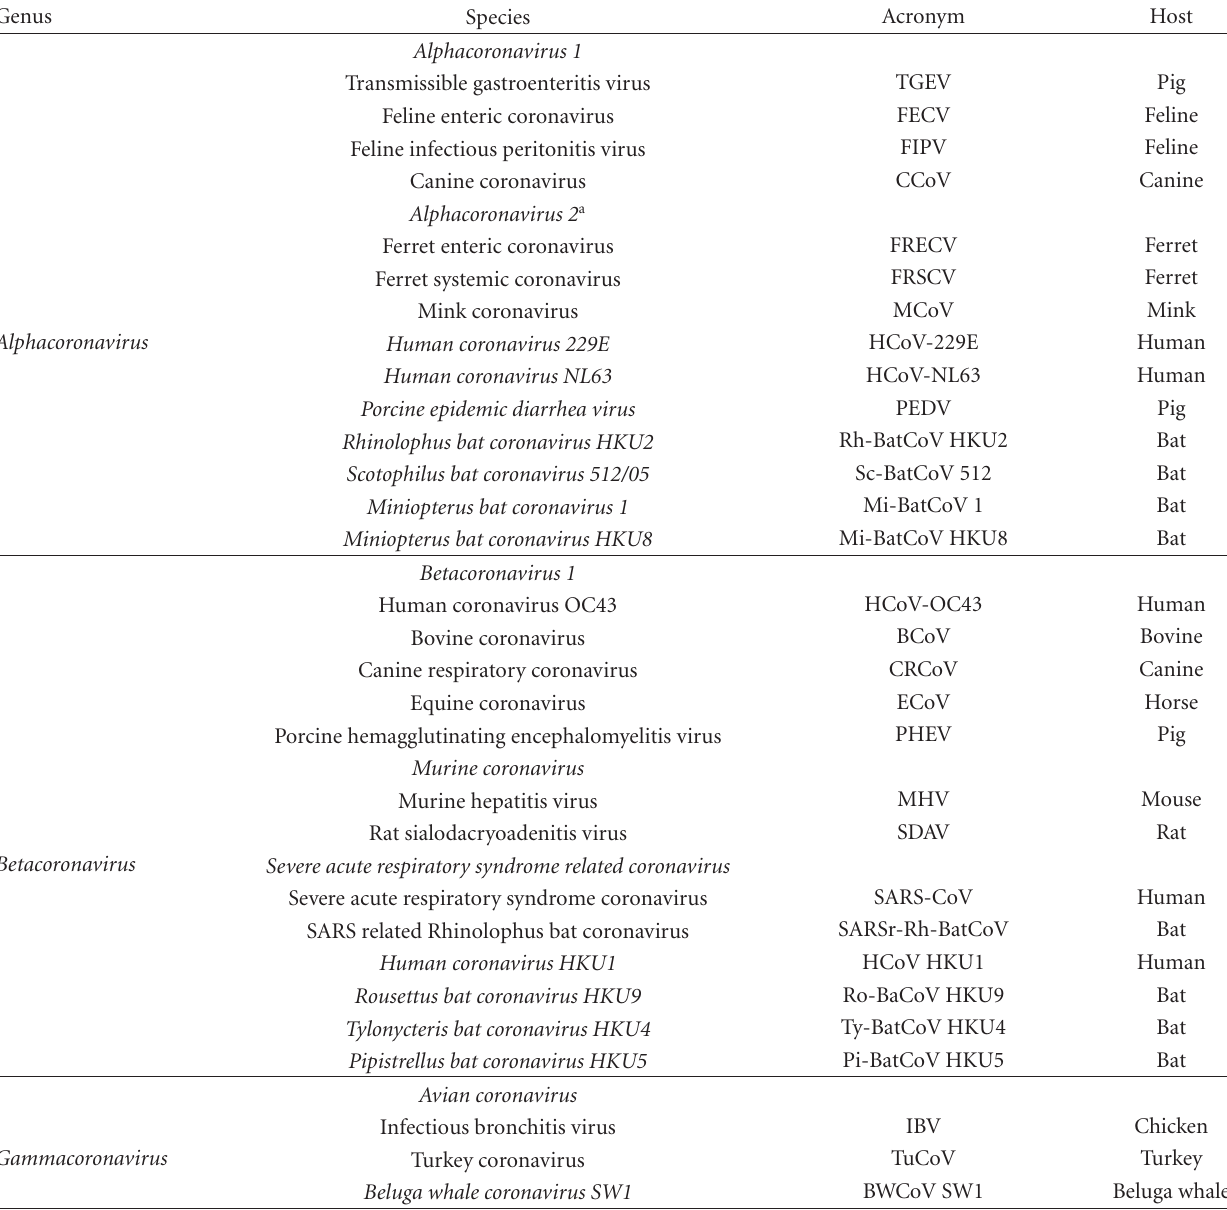
Table 1: Coronavirus genera, species, and representative